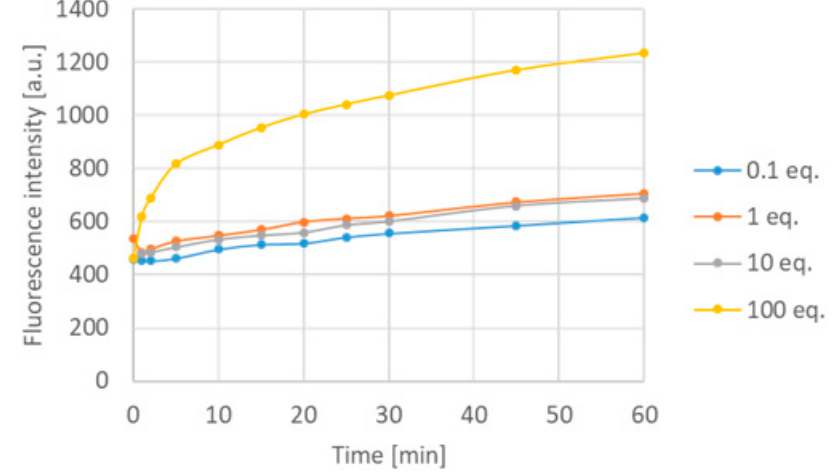
Figure 8. Time ‐ dependency of the emission of 12a in aqueous solution at 489 nm. Figure 8. Time-dependency of the emission of 12a in aqueous solution at 489